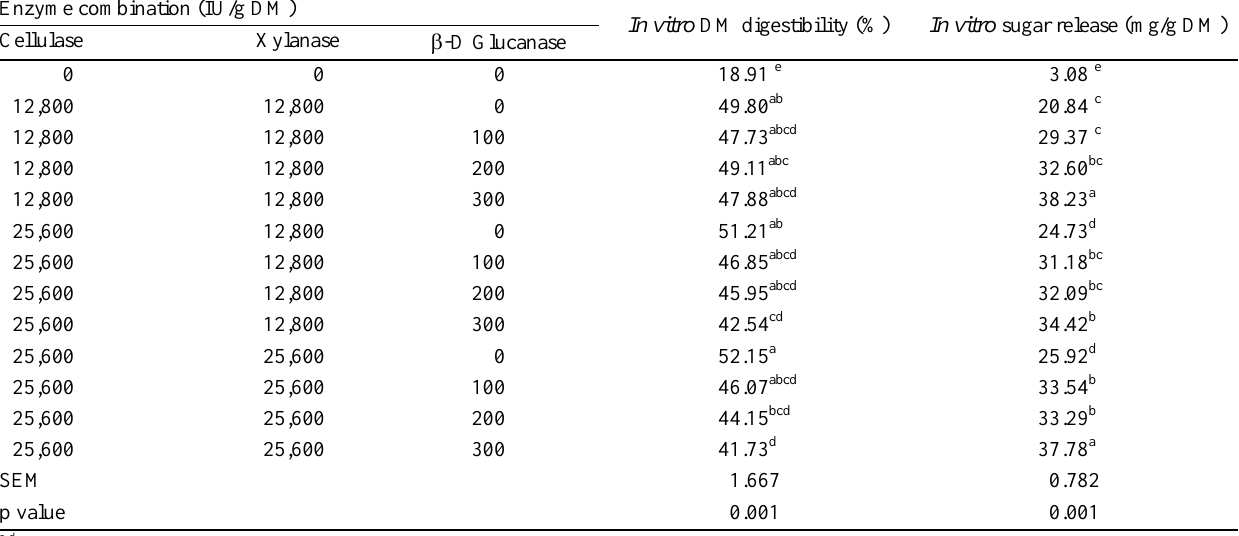
Table 3. In vitro DM digestibility (%) and total sugar release (mg/g DM) maize stover supplemented with various combinations of cellulase and xylanase Enzyme combination (IU/g